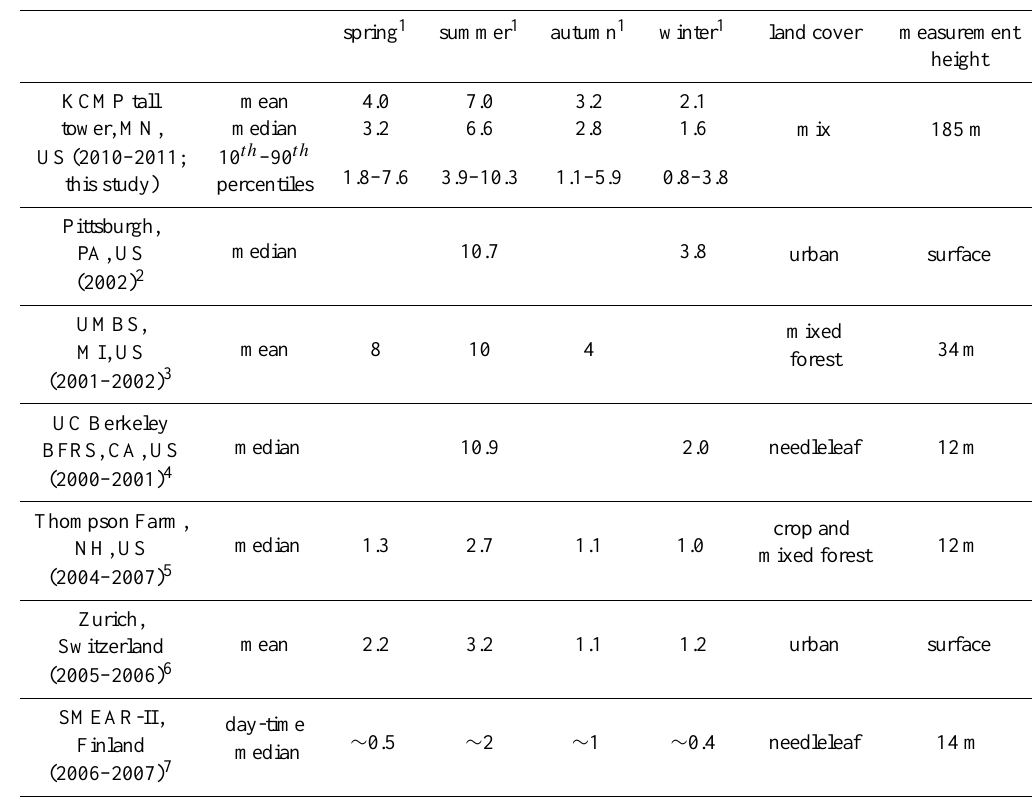
Table 1. Seasonality of atmospheric methanol abundance (ppbv) observed at the KCMP tall tower in the US Upper Midwest and comparison with other